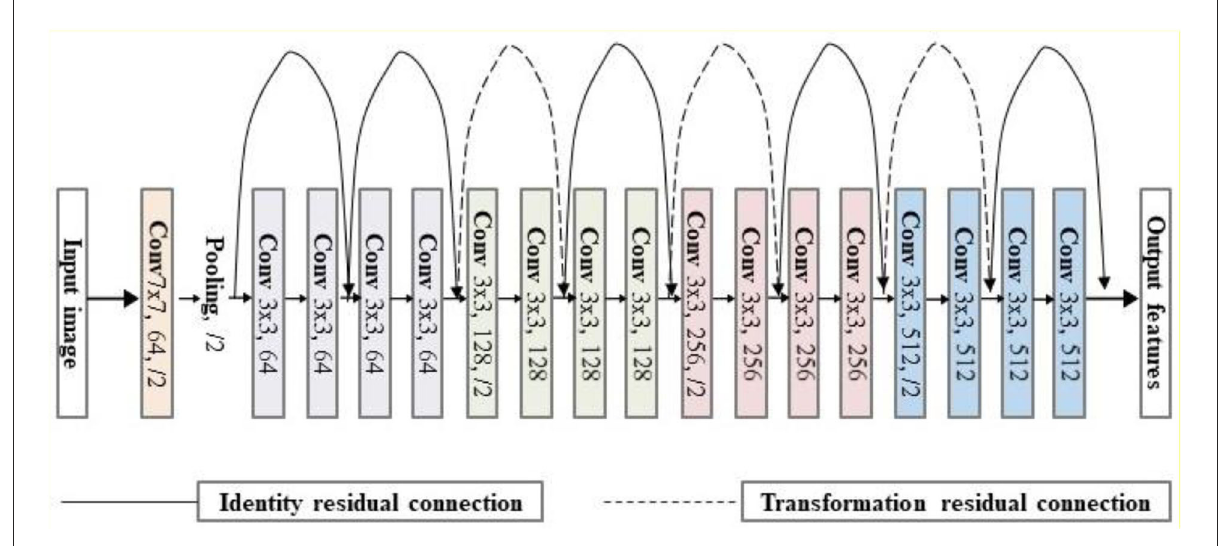
FIGURE3 ResNet-18 network structure.